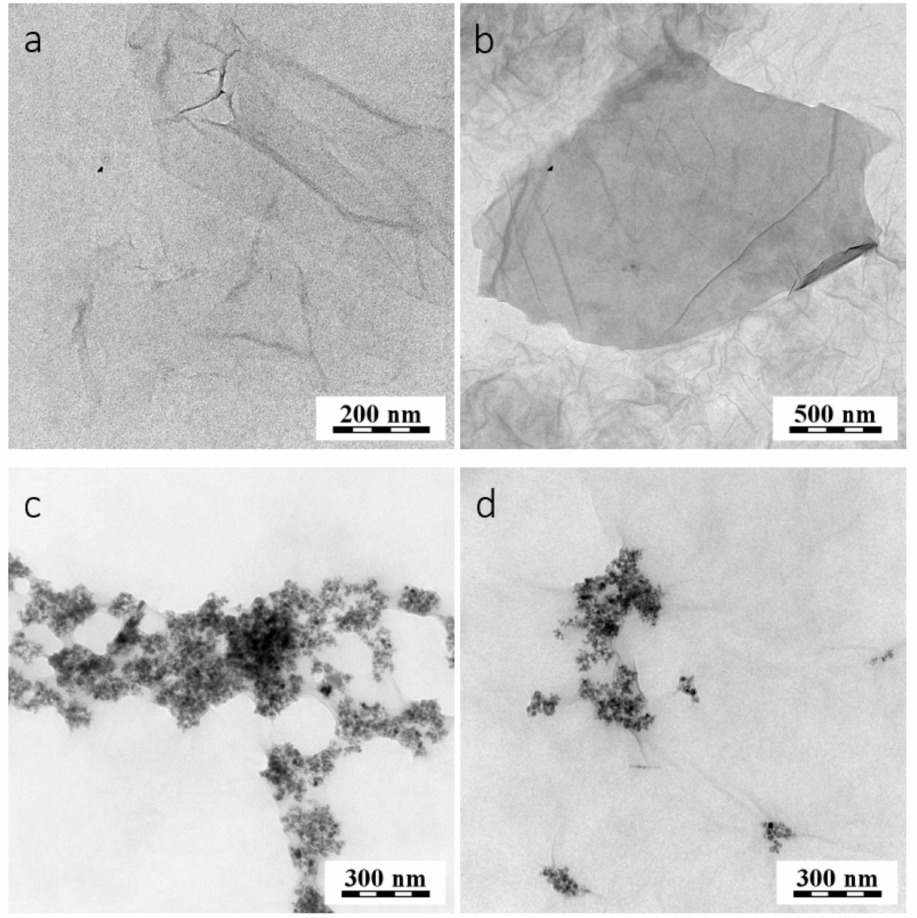
Figure 7. Transmission electron microscopy (TEM) micrographs of the ( a , b ) pure GO platforms; ( c ) graphene oxide platforms with magnetic nanoparticles modified antibodies (GO-MNps-MAb), and ( d ) graphene oxide platforms with magnetic nanoparticles modified antibodies in the presence